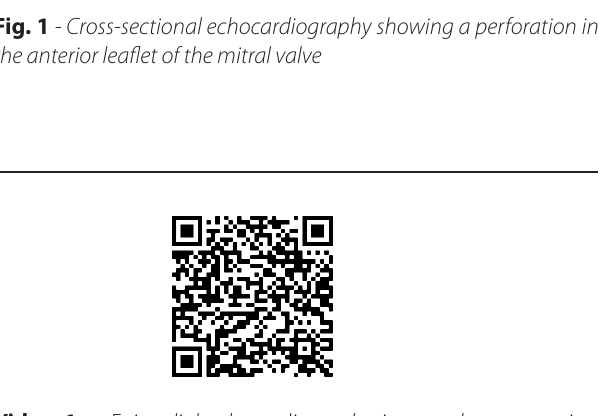
Video 1 - Epicardial echocardiography in complement to view more details.